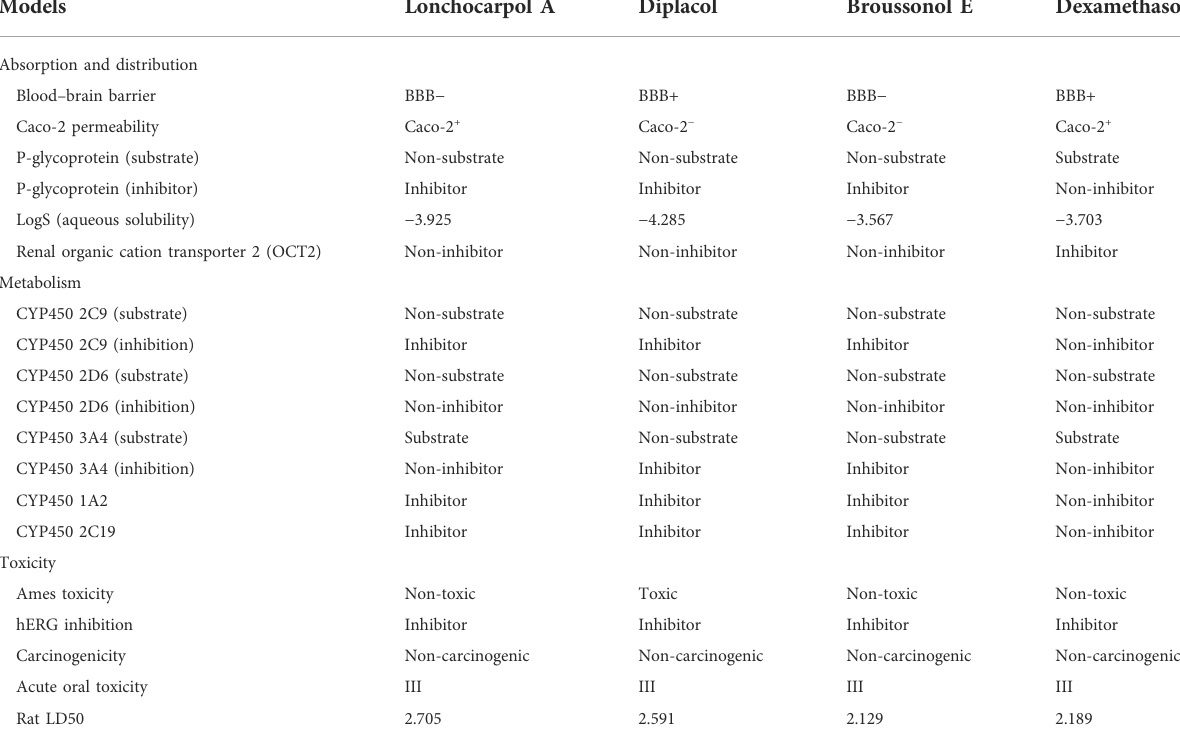
TABLE 7 Pharmacokinetics pro fi le of top four compounds.